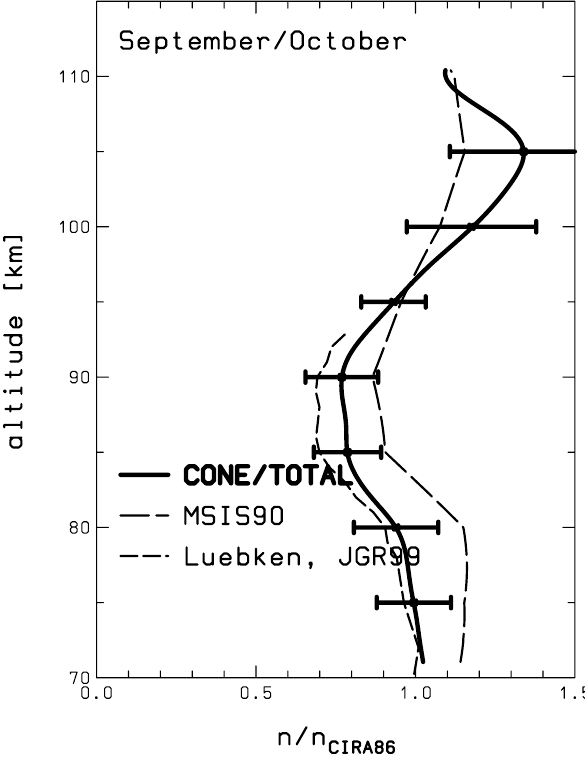
Fig. 10. As for Fig. 9 but for the months September and